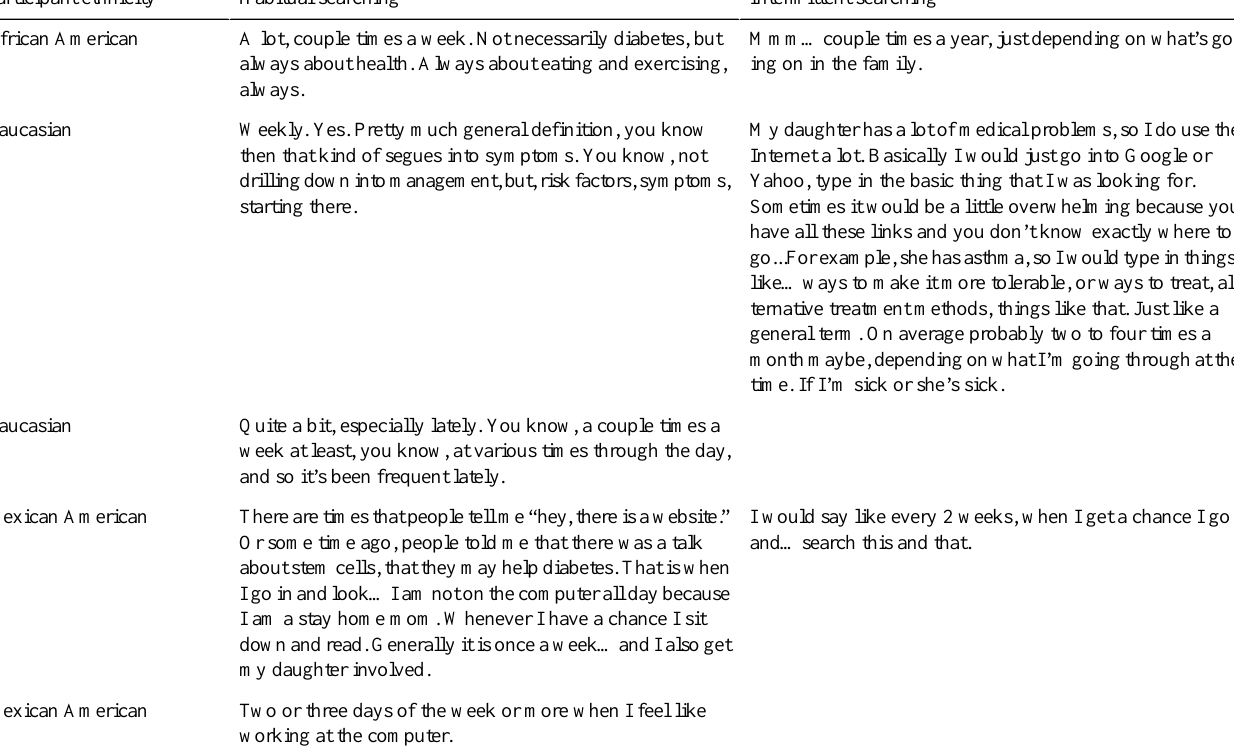
Intermittent searchingHabitual searchingParticipant